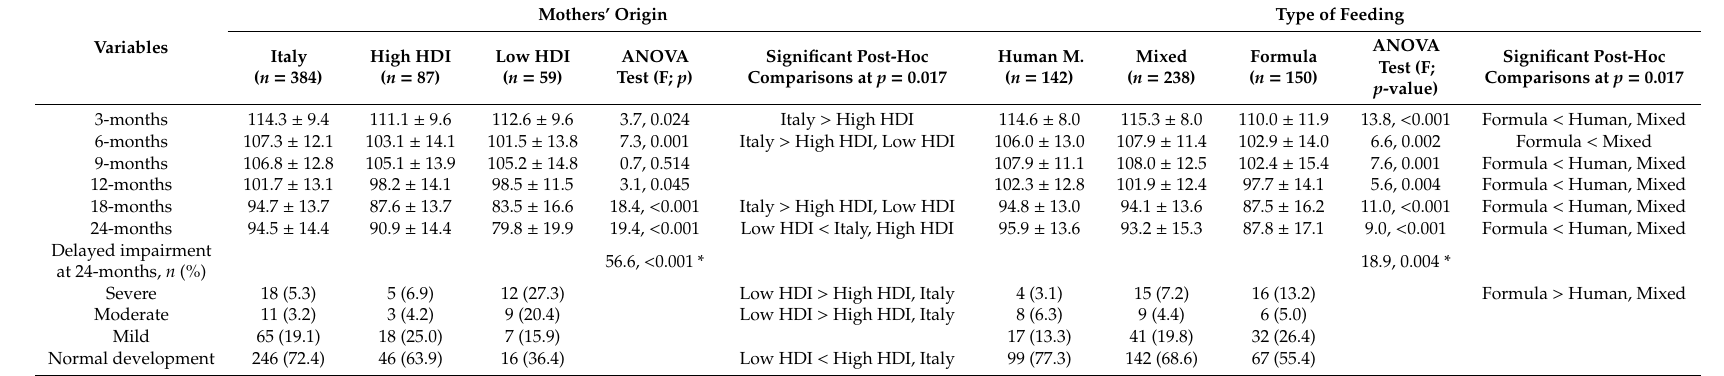
Table 3. Mean scores of the revised Gri ffi ths Mental Development Scales (GMDS-R) General Quotient at follow-up and prevalence of delayed impairment at 24-months by mother’s origin and type of